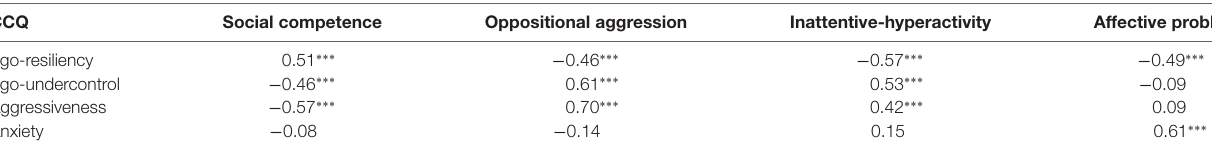
TABLE 2 | Concurrent correlations between children’s CCQ personality variables and problem behavior at age six.